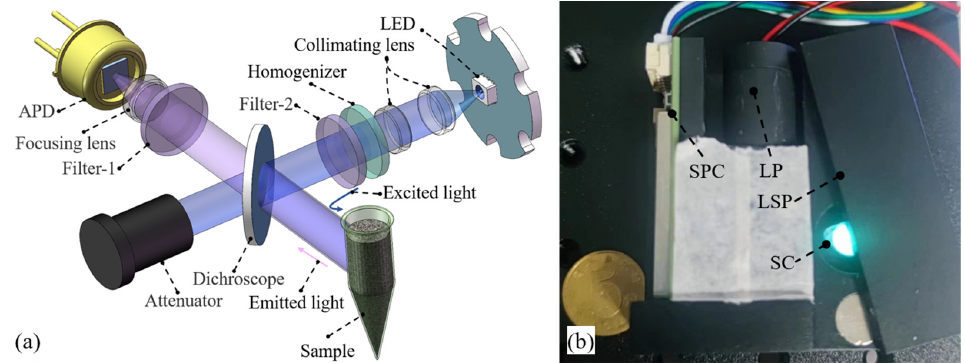
Figure 2. ( a ) Schematic view of the module configuration. APD: Avalanche Photodiode; LED: Light-Emitting Diode. ( b ) Photograph of the module during the testing process. LP: Light Path; SPC: Signal Processing Circuit; LSP: Light Shielding Plate; SC: Sample Cell.